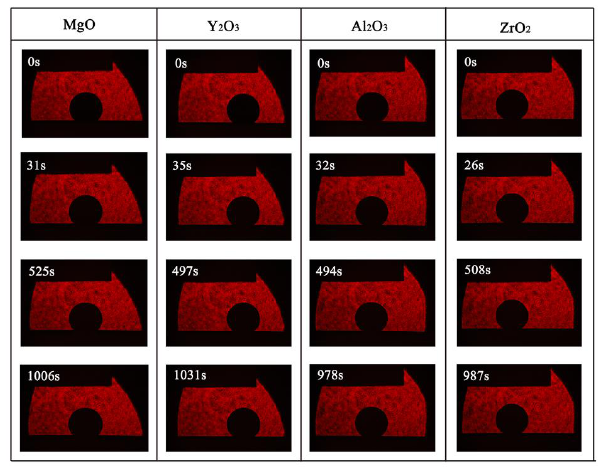
Figure 4. Wetting process of the Ni-20Co-20Cr-10Al-1.5Y alloys on various ceramic